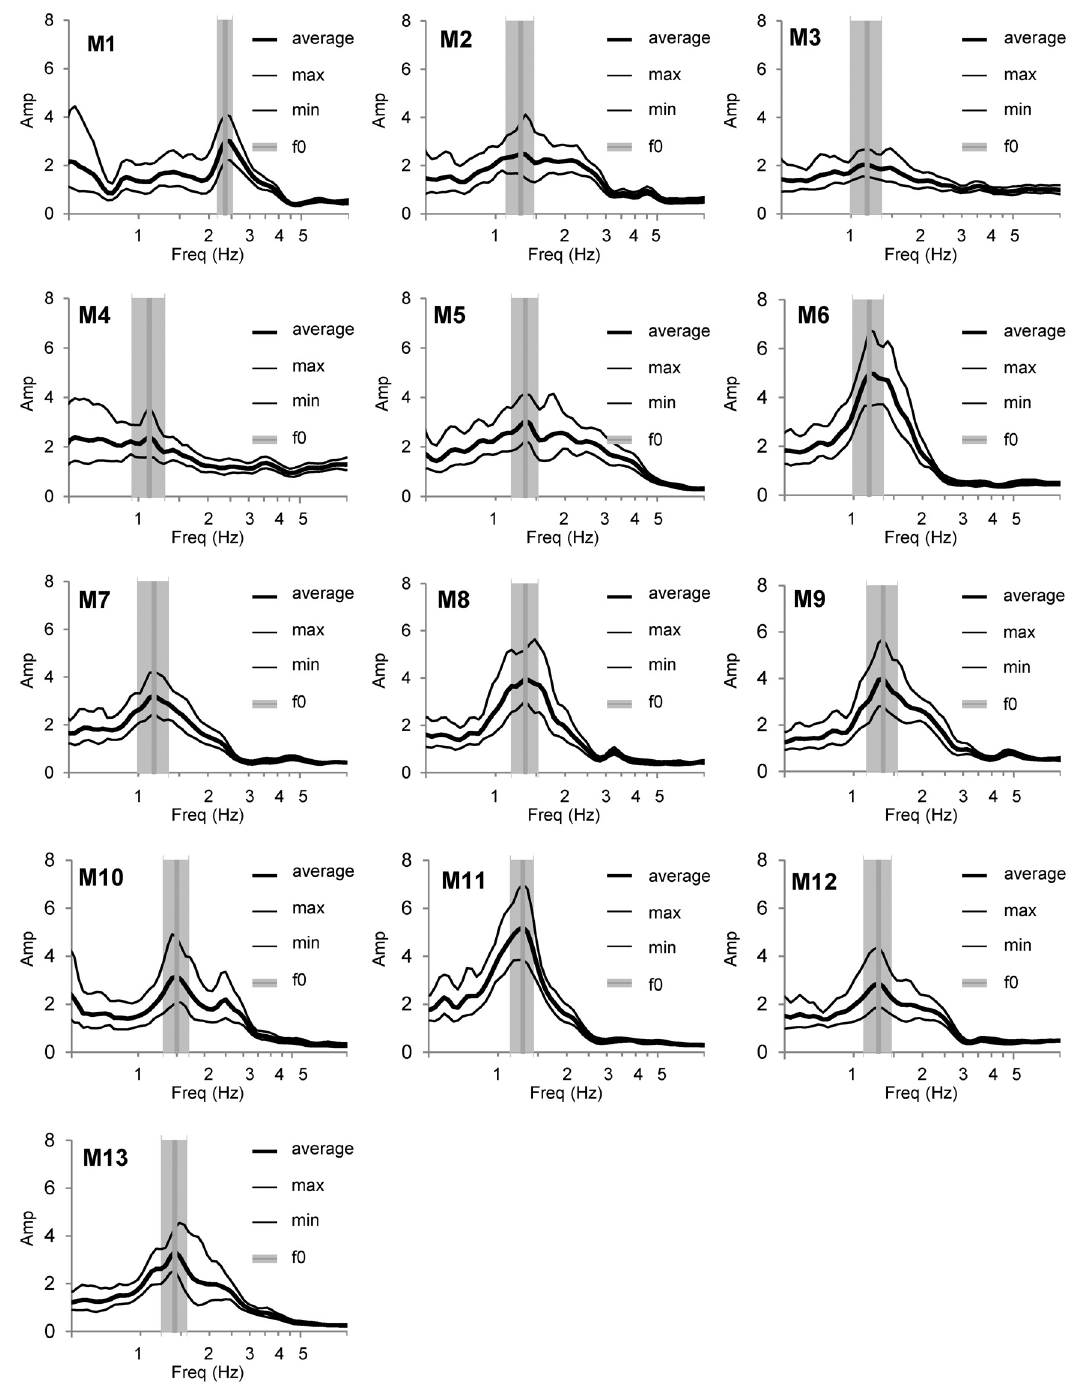
Figure 9. H/V curves computed for each